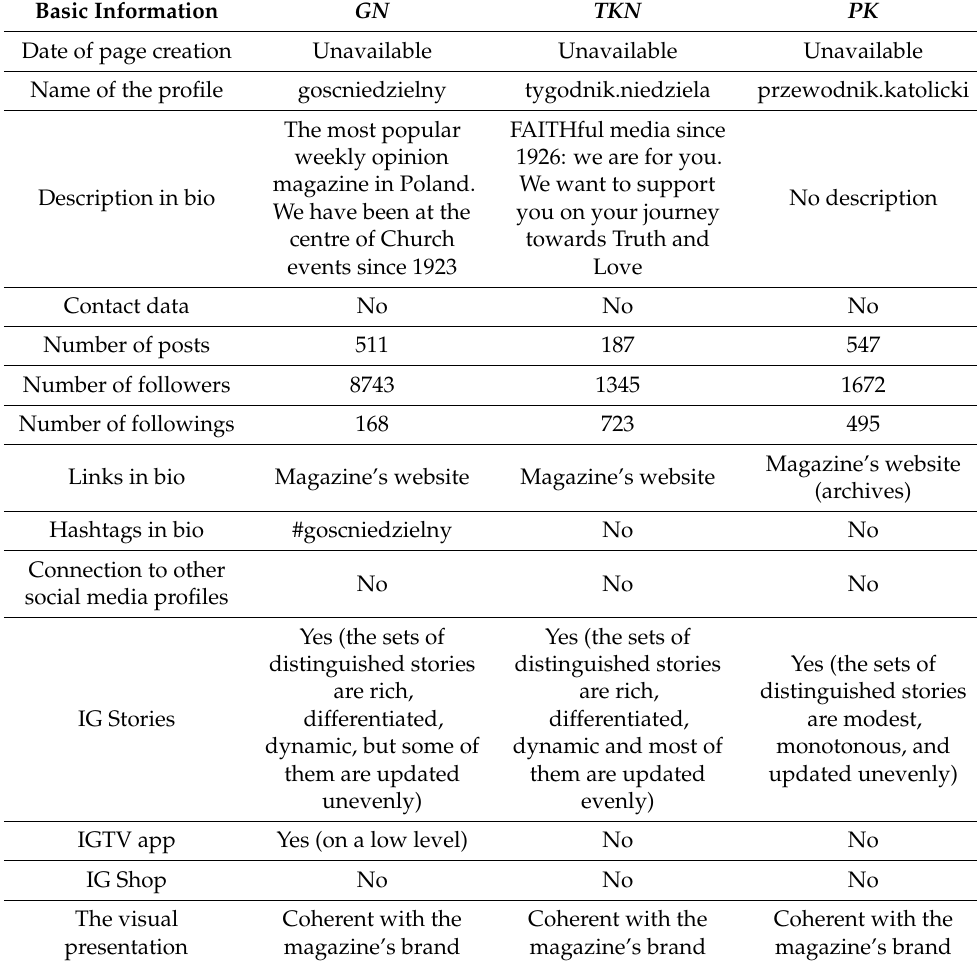
Table 2. Comparison of the IG profiles—analysis results (as of 27 July